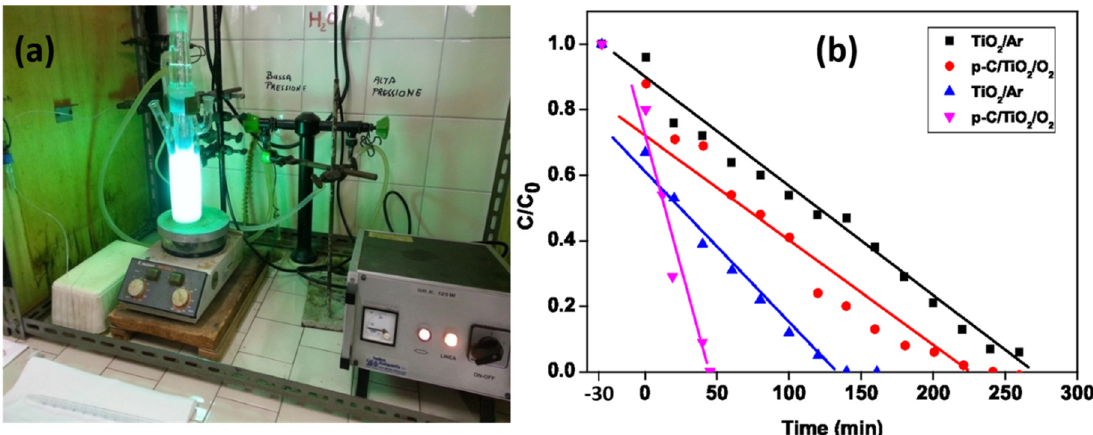
Figure 10. ( a ) Experimental setup for the photodegradation of phenol; ( b ) zero-order decrease in the concentration of phenol (1.0 mM, pH 3) in the absence and presence of oxygen under UV irradiation.